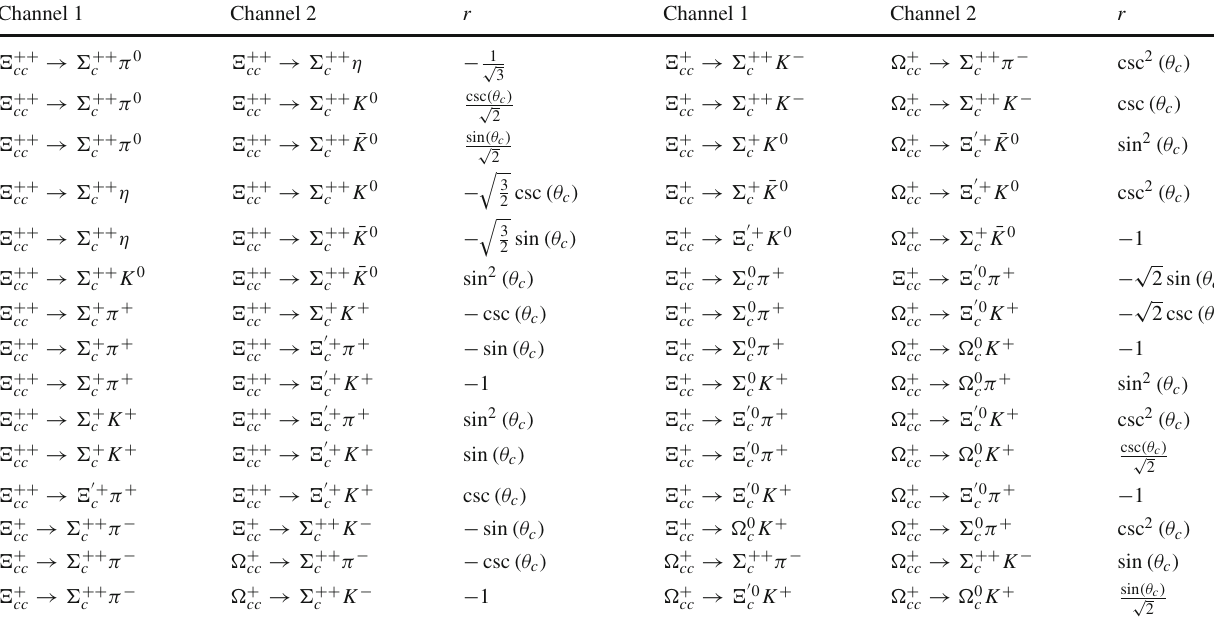
Table 10 Relations for Cabibbo-allowed, singly Cabibbo-suppressed and doubly Cabibbo-suppressed processes in Table 6 Channel 1